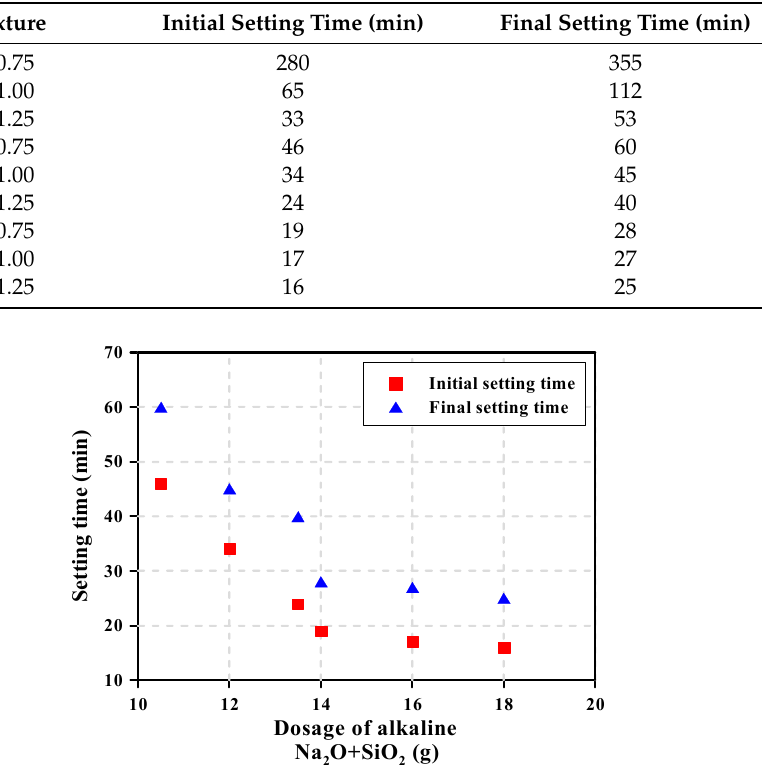
Table 4. Vicat test results of AAS pastes.